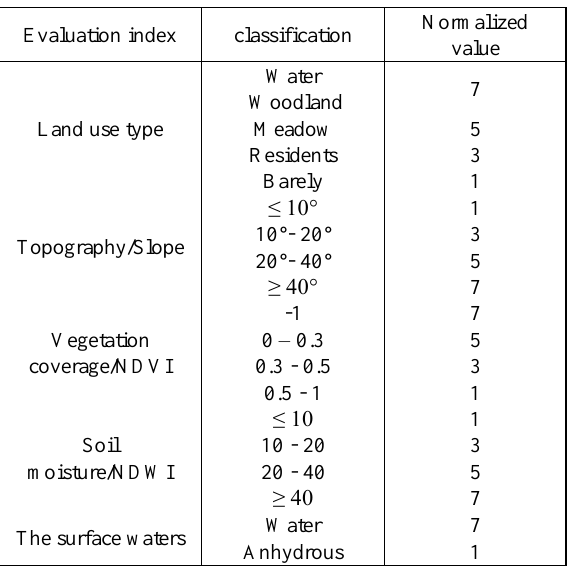
Table 1 Classification of evaluation indicators and standardization